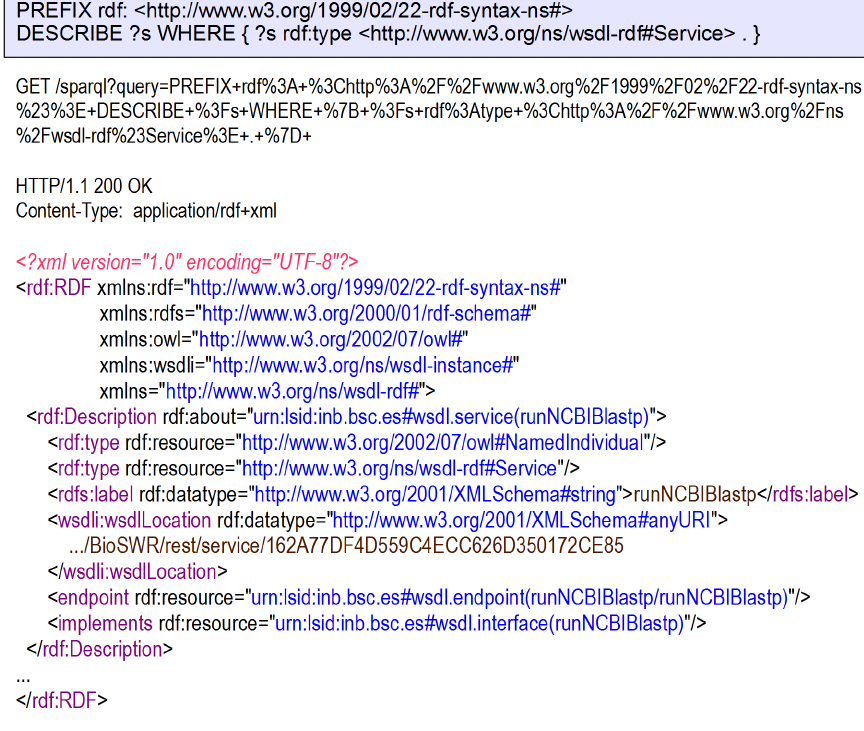
Figure 2. Find all registered Web services via SPARQL DESCRIBE query. doi:10.1371/journal.pone.0107889.g002 PLOS ONE |